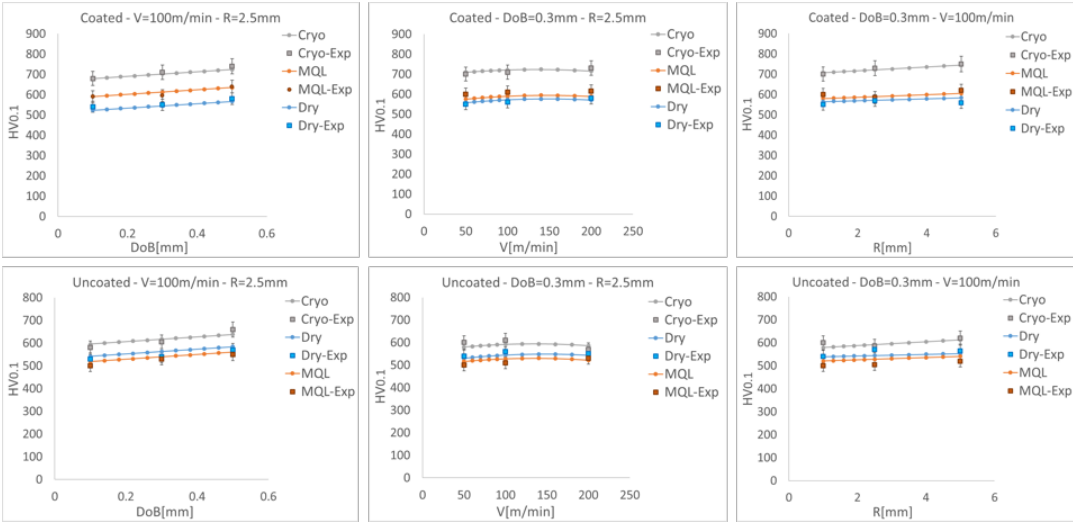
Table 3. Values for hardness constants in varying lubro / cooling and coating